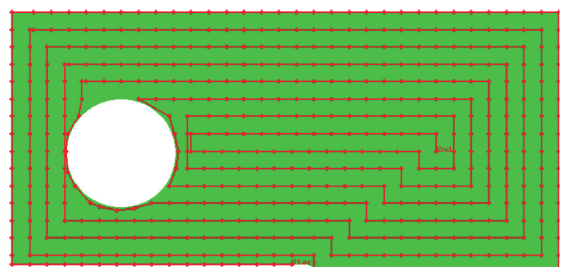
Figure 1: The extraction path of reference potential probe